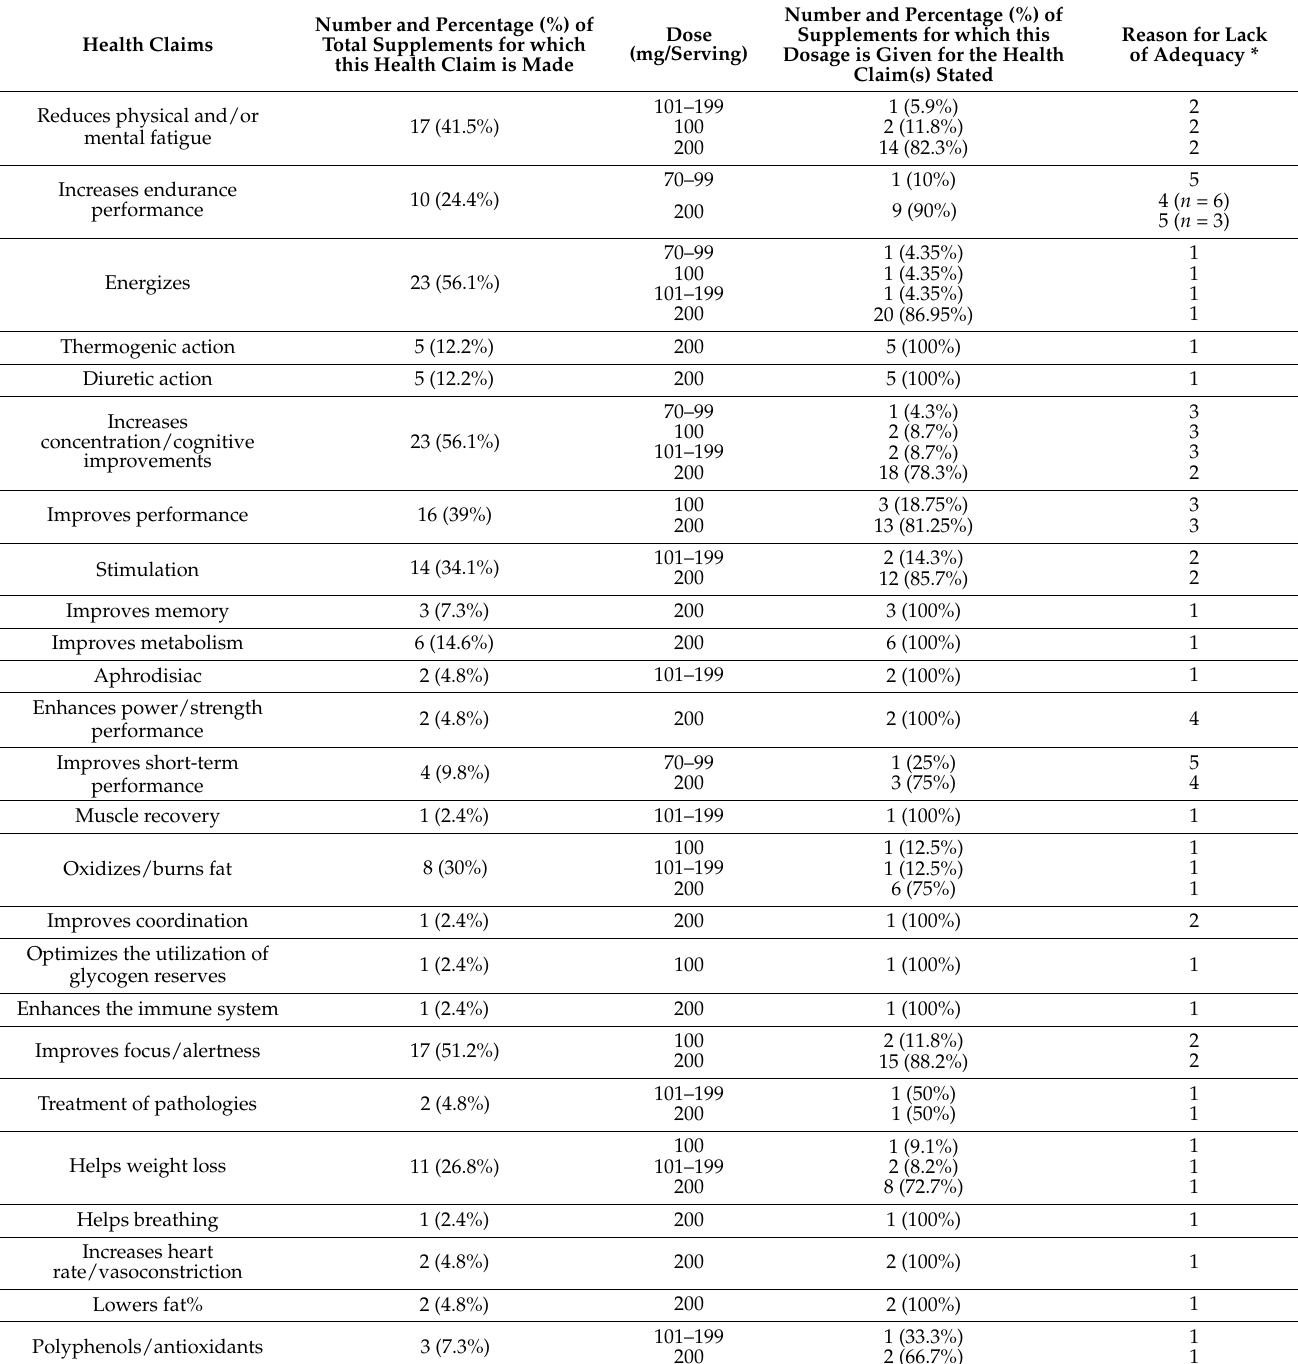
Table 1. Distribution of caffeine supplement doses according to health claims and their reasons of adequacy with European Food Safety Authority (EFSA) scientific